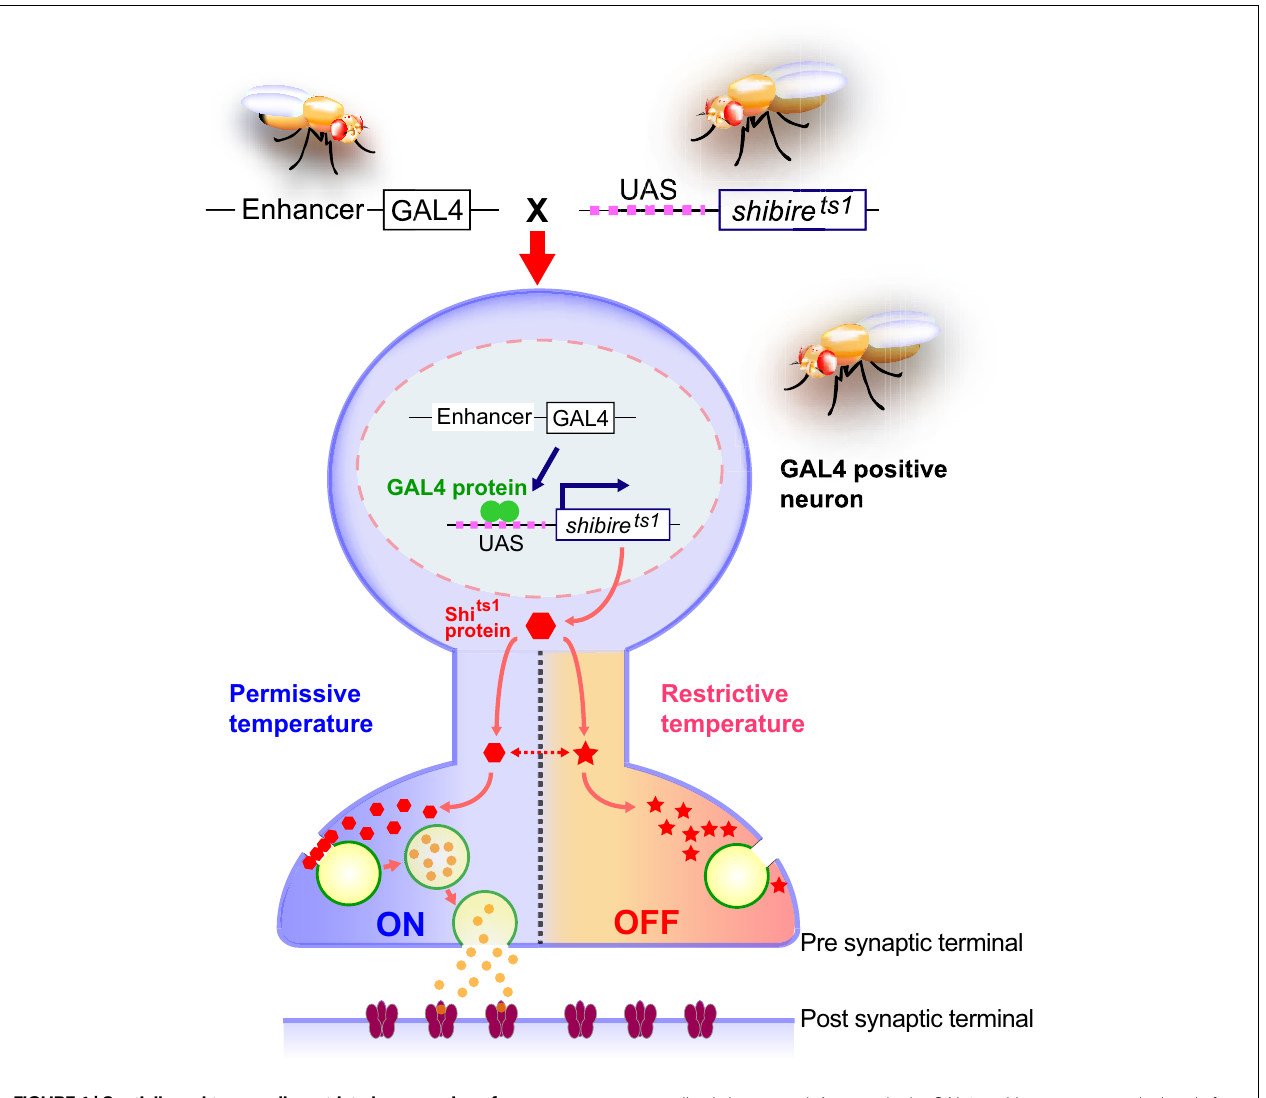
recycling is interrupted. As a result, the GAL4-positive neurons are depleted of synaptic vesicles and synaptic transmission is blocked. Behavioral consequences of spatial and temporal suppression of neurotransmission can be observed in free-moving animals. The shi ts1 product regains its activity and synaptic vesicles are restored immediately after the animals are returned to permissive